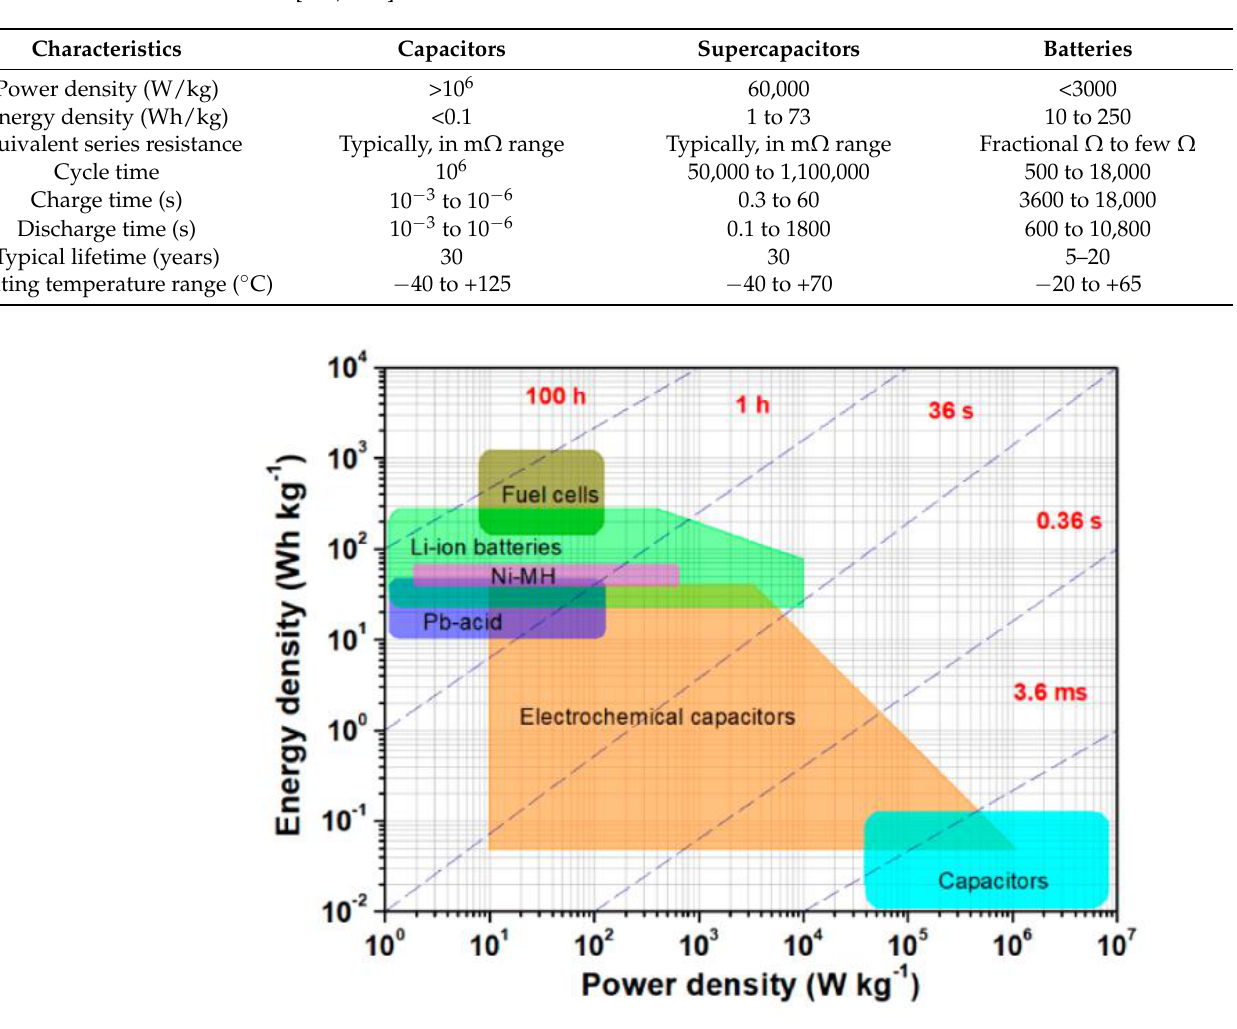
Table 1. Comparison of characteristics of supercapacitors versus batteries and conventional capac- itors [1 – 3,5 – 10] .